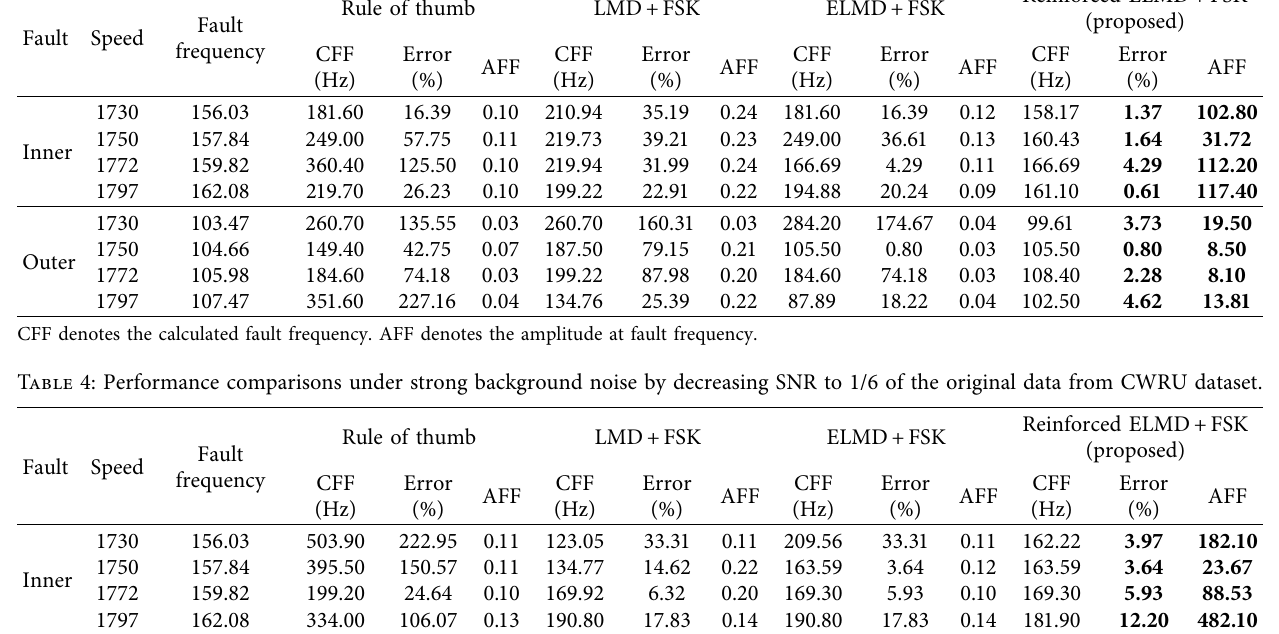
Table 3: Performance comparisons under strong background noise by decreasing SNR to 1/5 of the original data from CWRU dataset. Fault Speed 1730 156.03 Inner